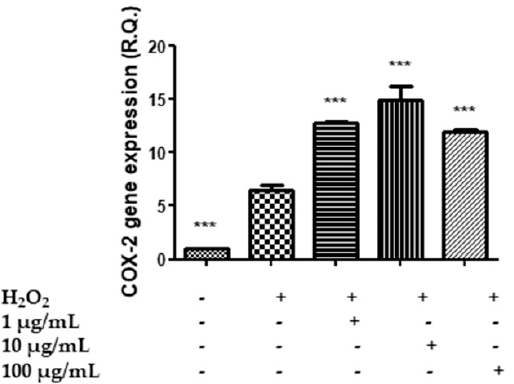
Figure 7. Effect of the HAE acetone water extract (1–100 µ g/mL) on COX-2 gene expression in hypothalamic HypoE22 cells exposed to H 2 O 2 ( µ M). ANOVA p < 0.0001; *** p < 0.001 vs. H 2 O 2.